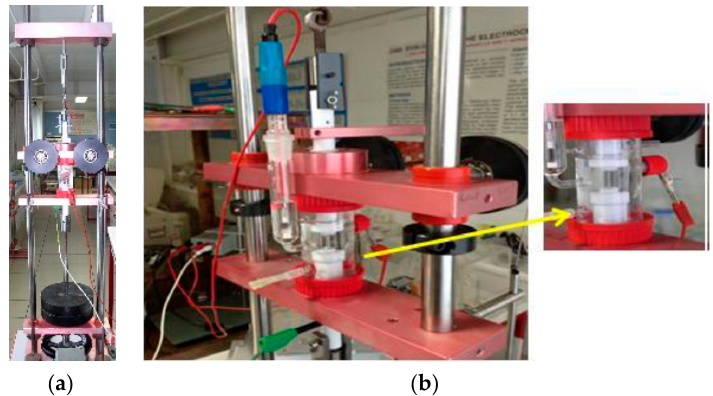
Figure 5. ( a ) The fatigue corrosion device; ( b ) detail of the electrochemical cell.